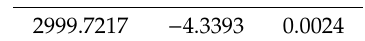
Table 6. Coe ffi cients of the polynomial for the equivalent temperatures in the mHS equation.